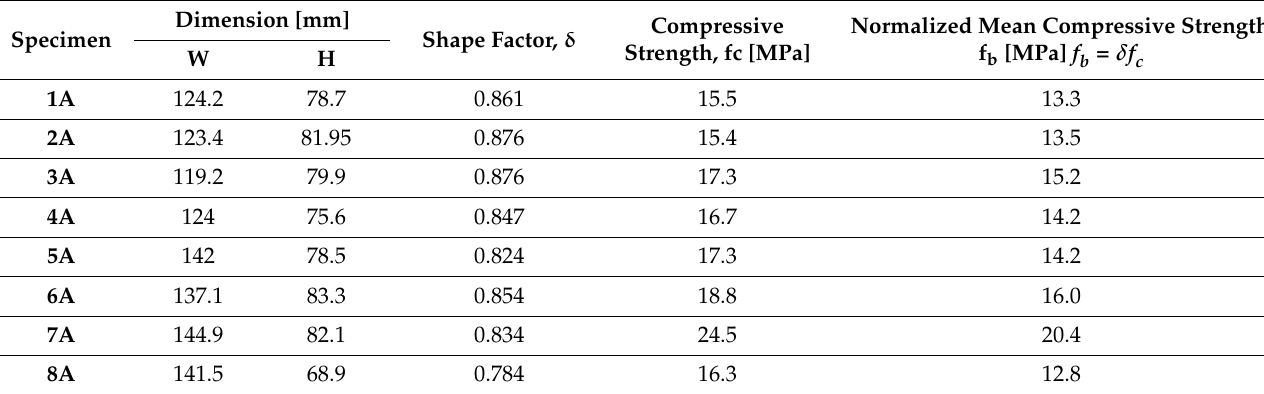
Figure 8. Satisfactory failures of specimen. Table 7. Standard compression test results.